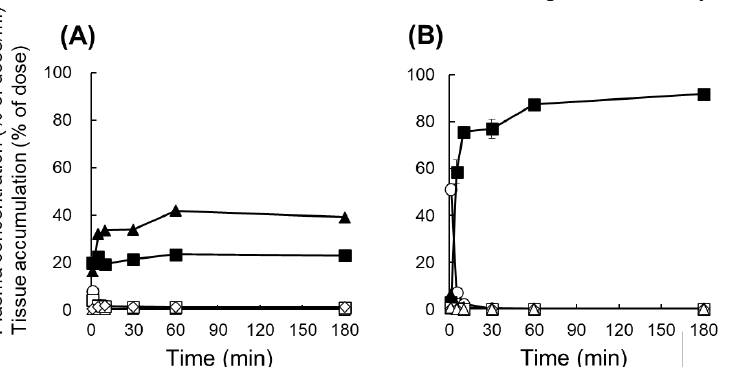
Figure 1. Plasma concentrations and tissue distributions of 111 In-labeled poly-L-lysine (PLL) ( A ) and 111 In-labeled Ser-poly-L-lysine (Ser-PLL) ( B ) after intravenous injection into mice. Data are means ± SE for three mice. ◯ , plasma; ▲ , liver; █ , kidney; ◇ , spleen; △ , heart; □, lung.